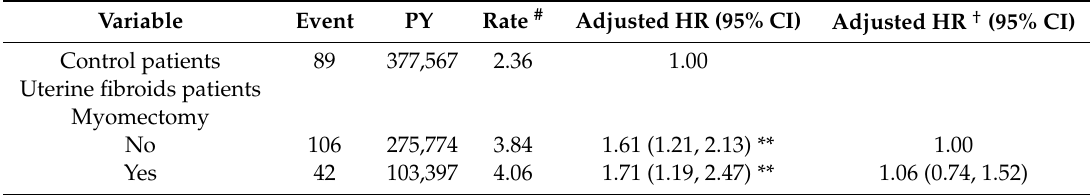
Table 3. Risk of thyroid cancer related to myomectomy in patients with uterine fibroids. Variable Event PY Rate # Adjusted HR (95% CI) Adjusted HR † (95% CI) Control patients 89 377,567 2.36 1.00 Uterine fibroids patients Myomectomy No